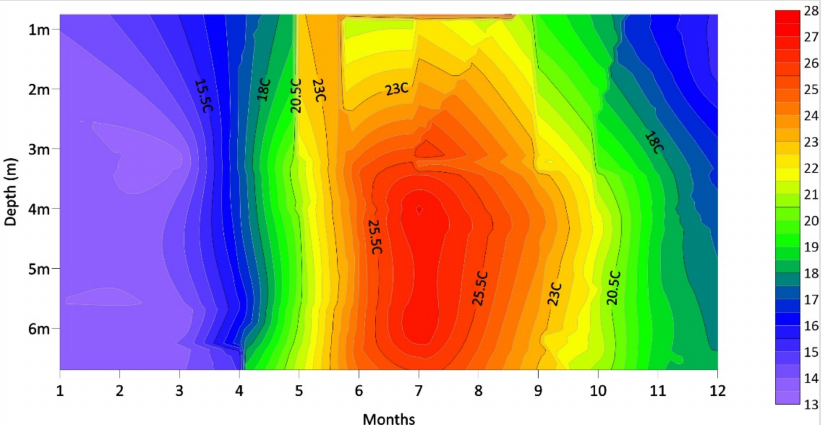
Figure 3. Contour plot of the water column temperature ( ◦ C) measured at both sample sites over the course of the study.